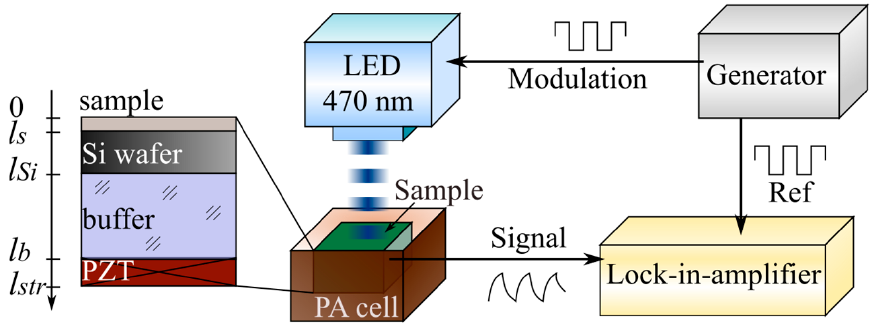
Figure 8. Sketch view of the experimental photoacoustic setup with piezoelectric detection.